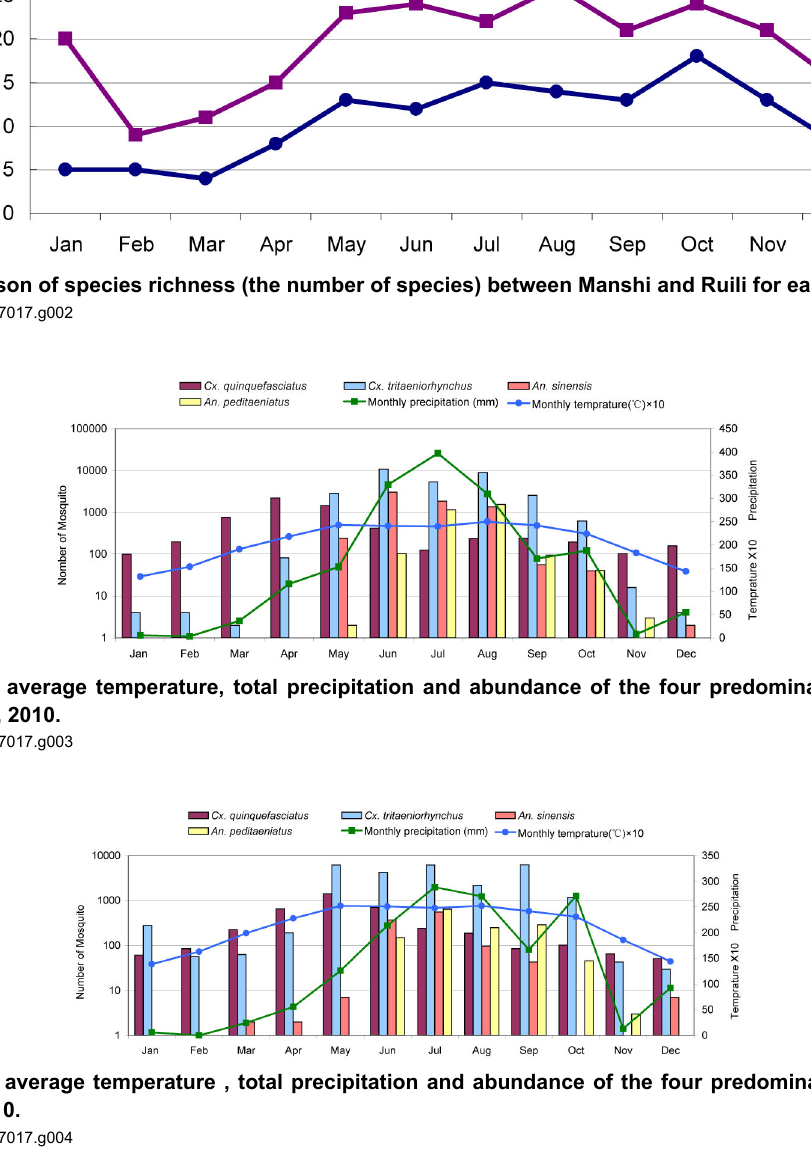
Table 4. Species richness (number of mosquito species) each month during 2010 in Mangshi and Ruili.